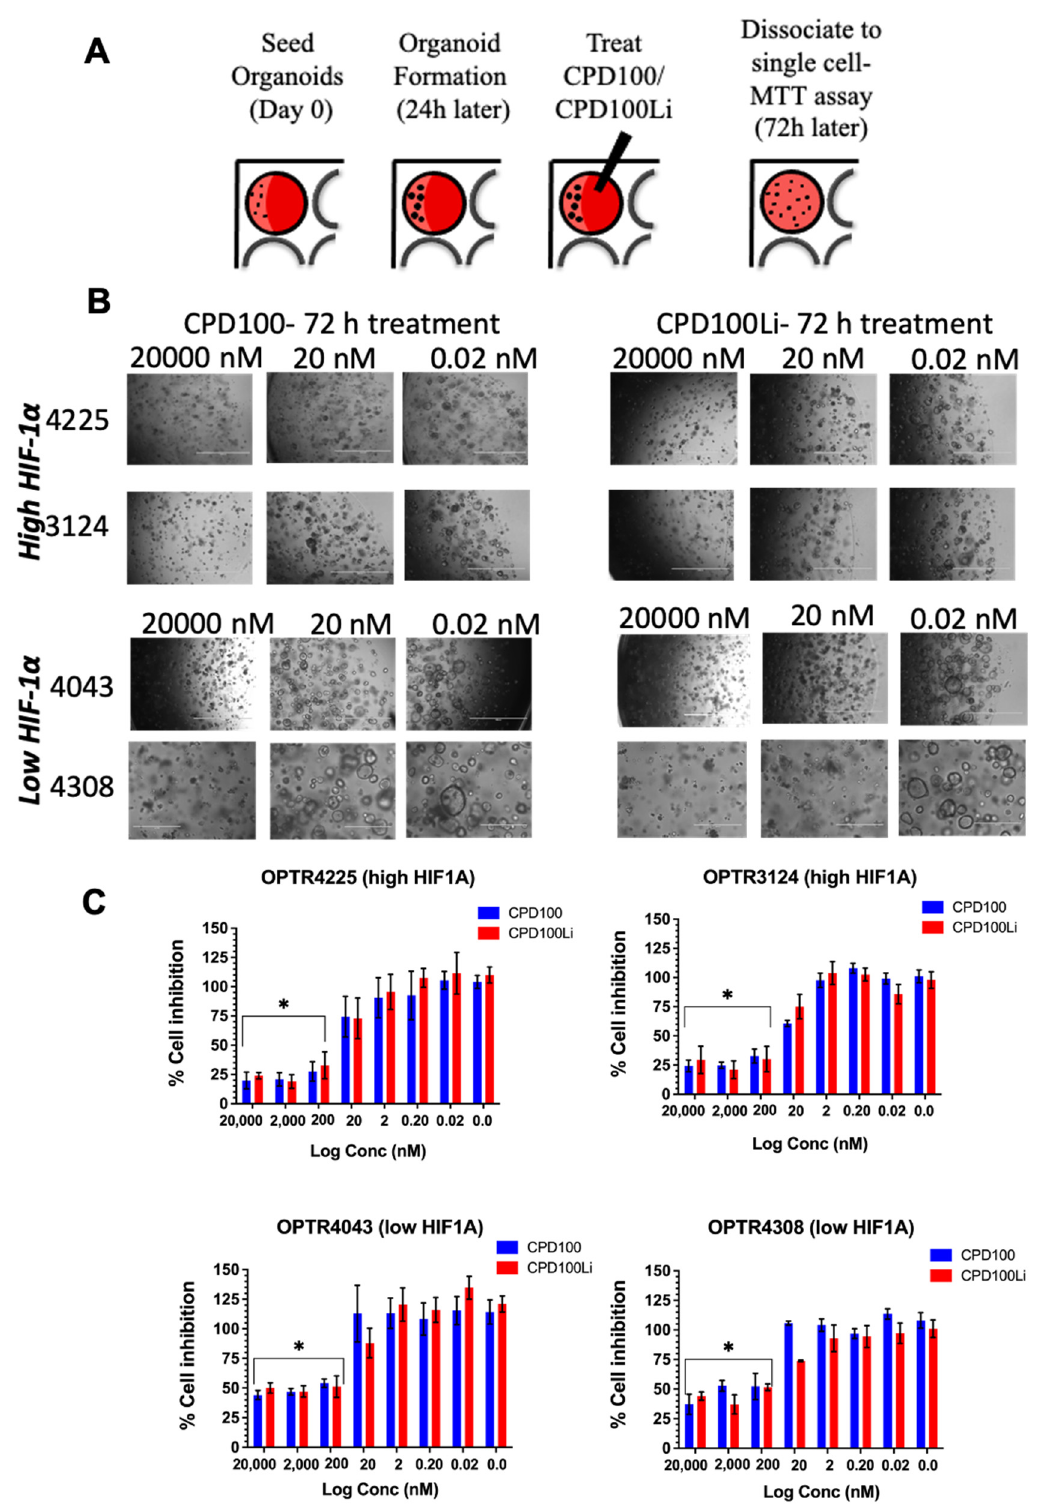
Figure 3. In vitro efficacy of CPD100 and CPD100Li in patient-derived organoids. Schematics of organoid development and treatment ( A ), bright-field images of two high and low HIF1A expressing organoids as a function of three concentrations after 72-h treatment with CPD100 and CPD100Li, scale bar represents 1000 μ m ( B ), and % cell inhibition as a function of CPD100 and CPD100Li 72-h post-treatment ( C ). Data represented as mean ± SD of four replicates. * ( p ≤ 0.05) represents statistical significance compared to the 0.02 nM treated group by the Student-paired t -test.